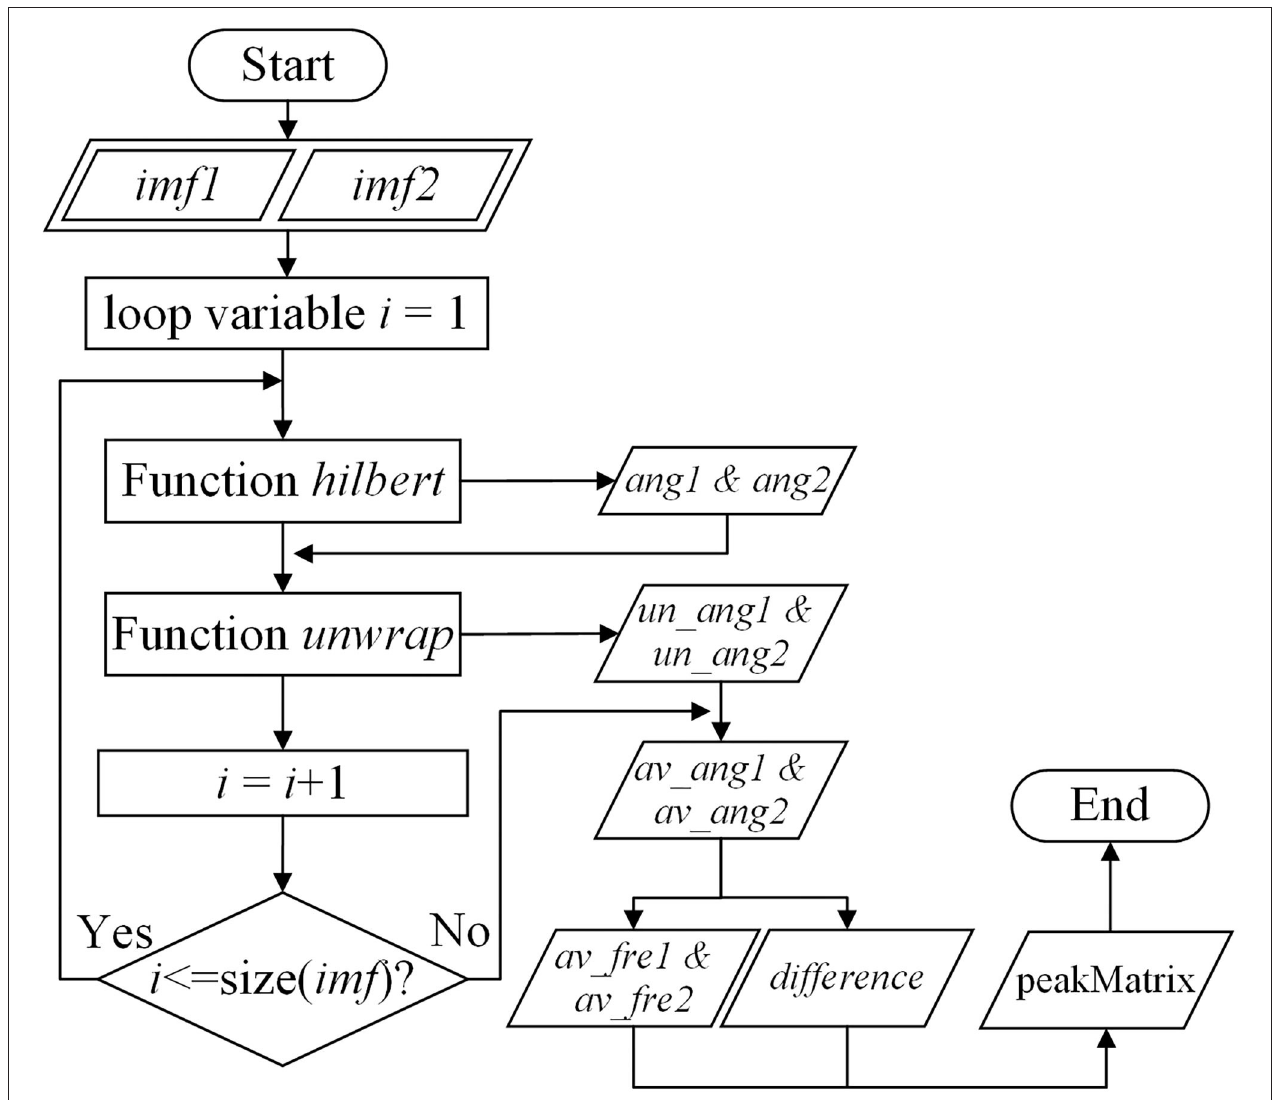
FIGURE 3 | The workflow of function PLseries